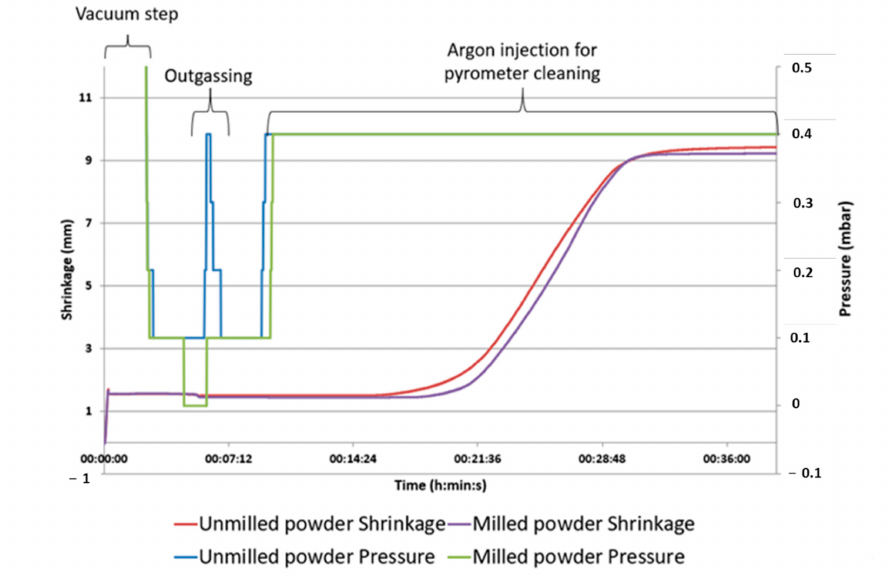
Figure 5. Sintering curves of milled and unmilled WMoTaNb